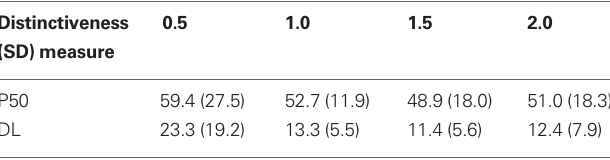
Table 3 | Median (iQr) of P50 and DL for all participants.